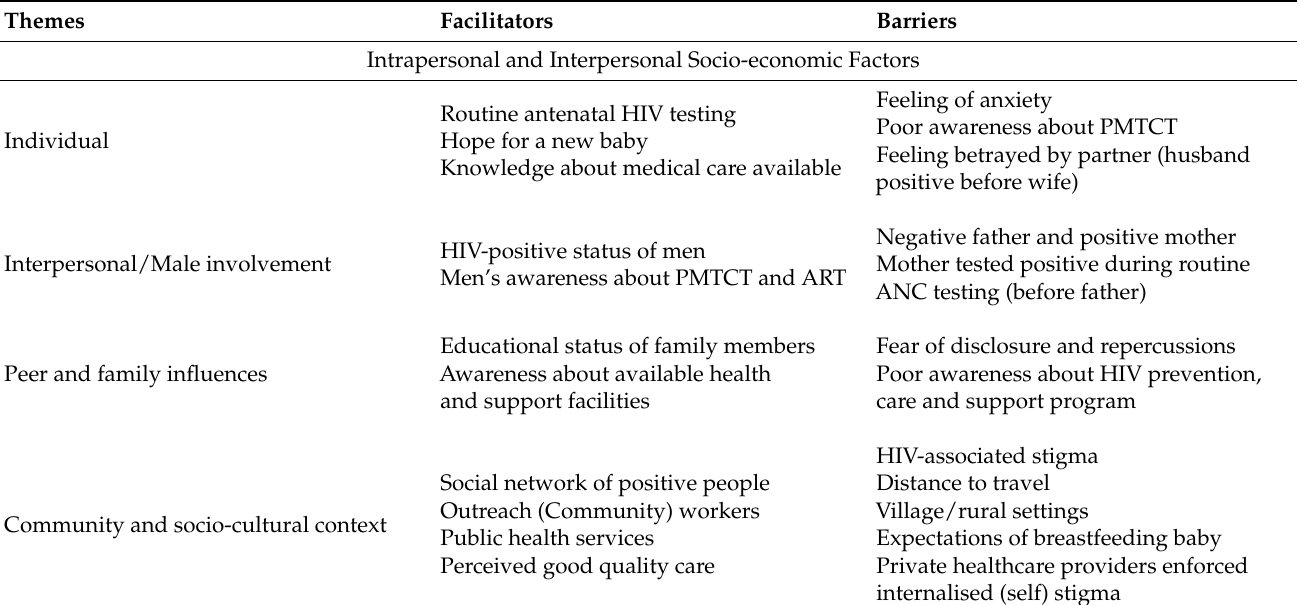
Table 2. SEM facilitators and barriers in